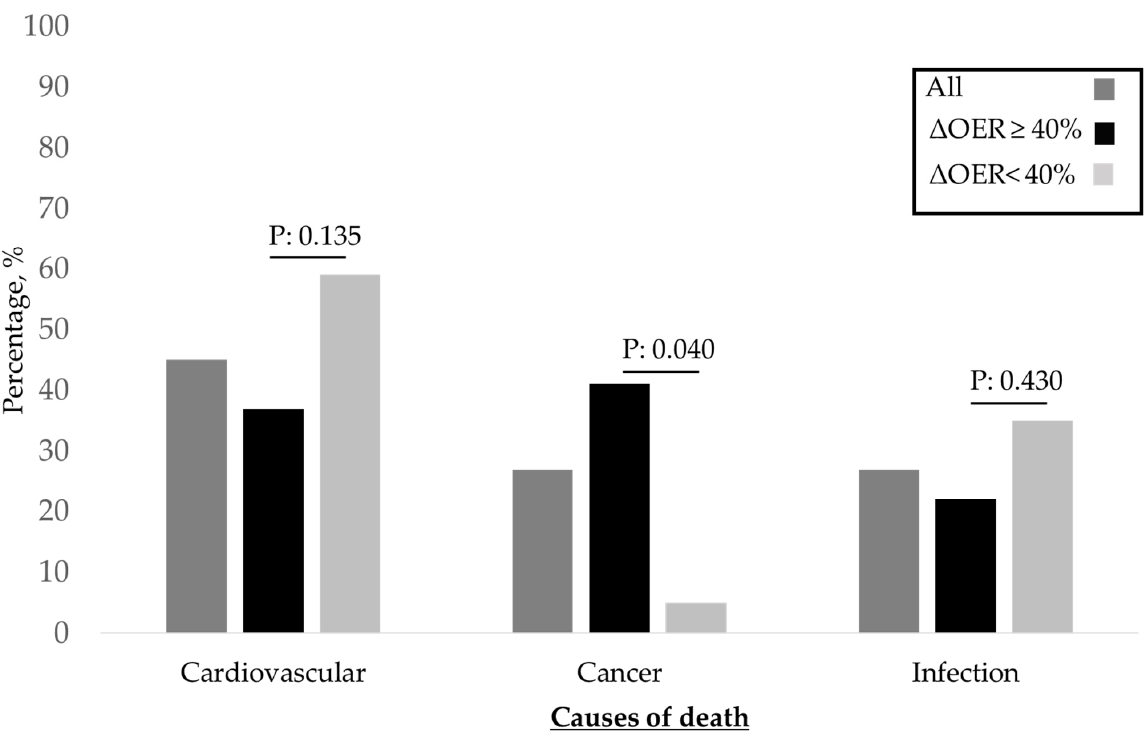
Figure 4. Incidence of causes of death in the entire population and in the ∆ OER ≥ 40% and ∆ OER < 40% groups. OER, oxygen extraction ratio; ∆ OER, variation in OER. Table 1. Clinical and biochemical characteristics of the enrolled population and of the two sub- groups ( Δ OER ≥ 40% and Δ OER < 40%).